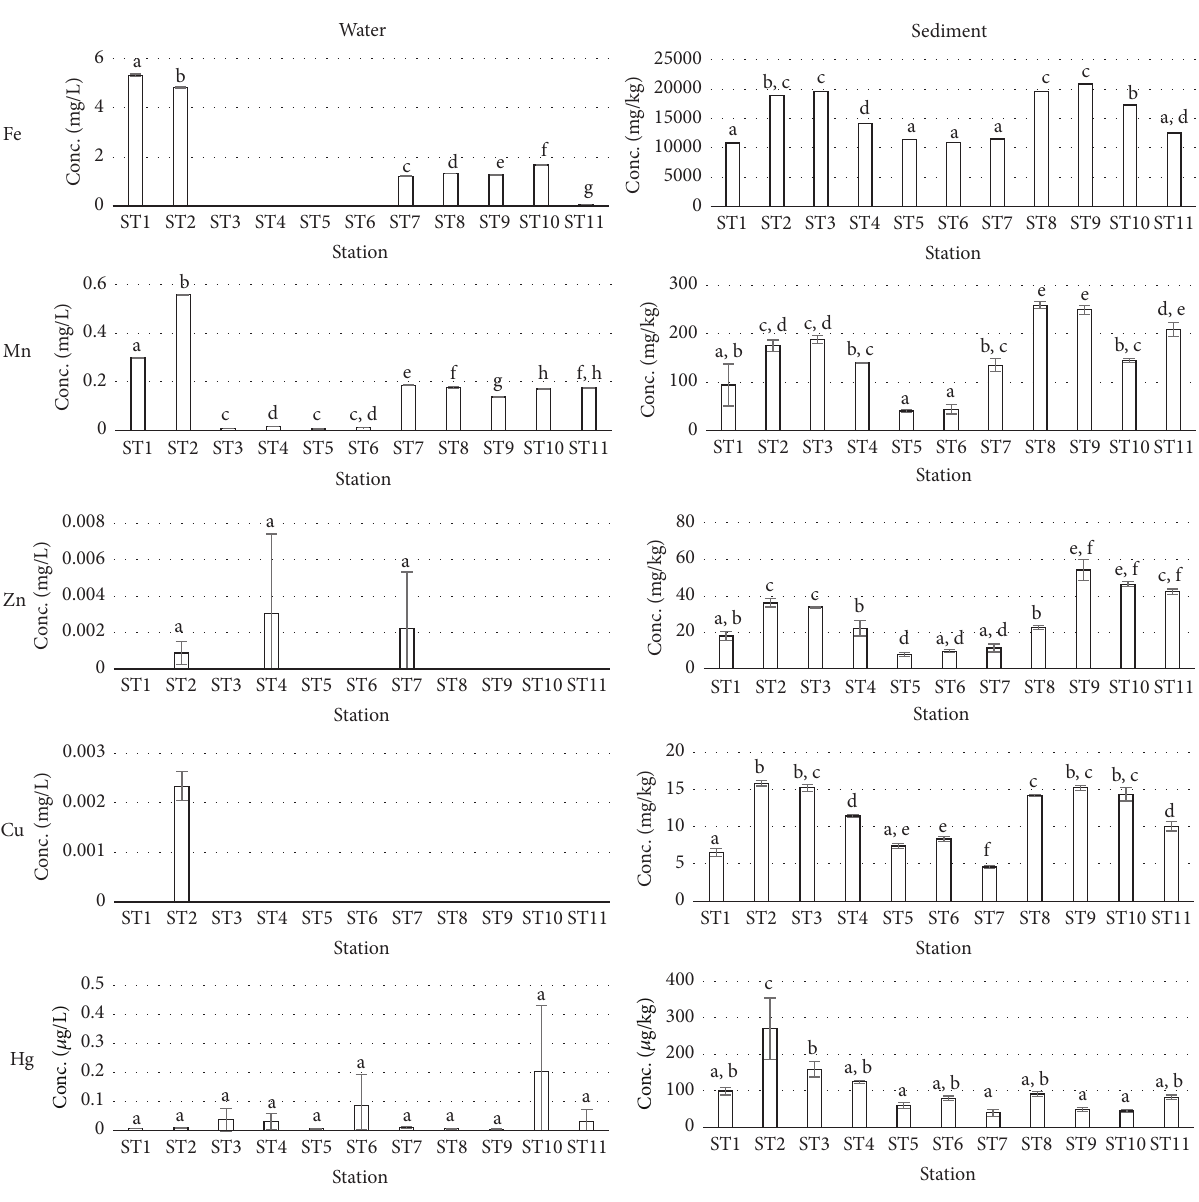
Figure 2: The average metal concentrations in water and sediment (different letters indicate significant difference at 𝑝 = 0.05 ).